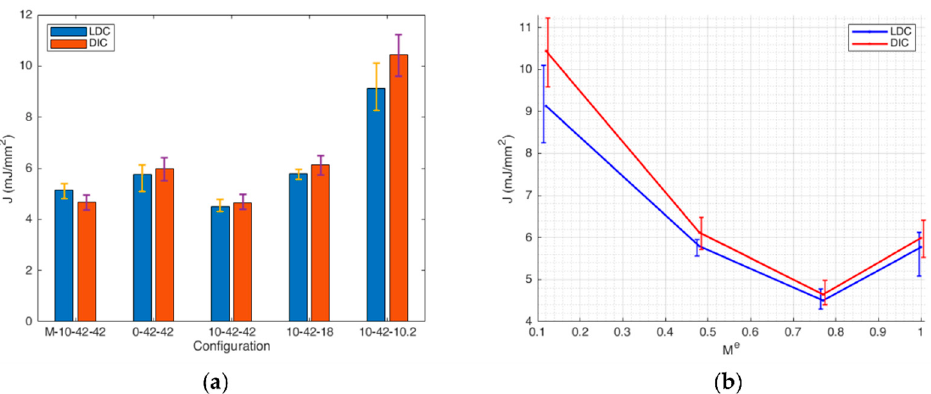
Figure 10. Comparison between the results obtained with the DIC method (blue) and the ones obtained with the LDC method (red). ( a ) Bar plot for the different test configurations; ( b ) J-integral plotted as a function of the mode mixity ratio M e .